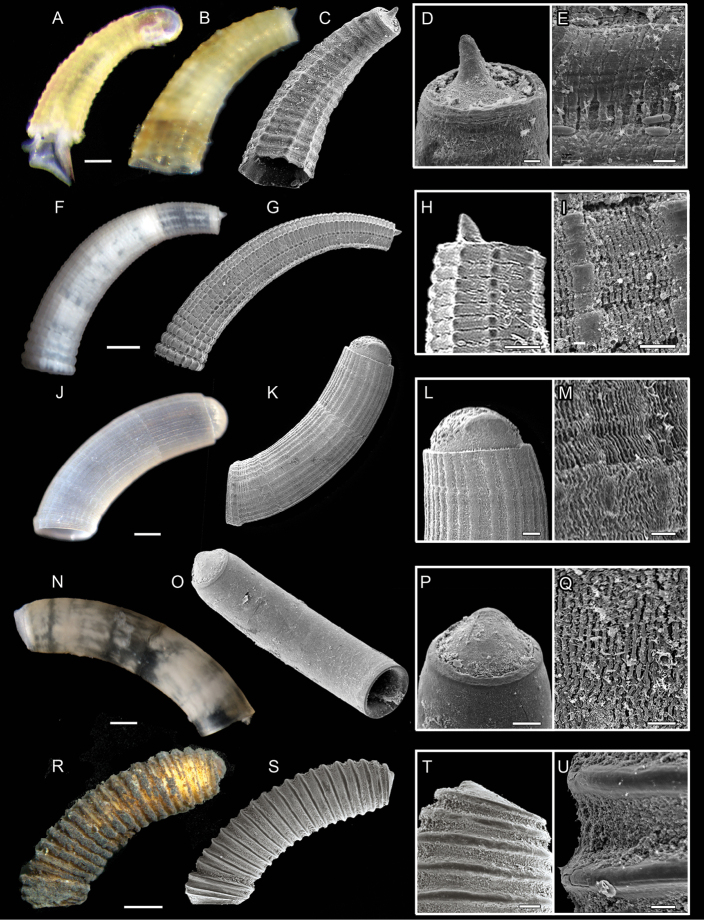
A–ECaecum
heptagonumA specimen USNM 1618866 juvenile specimen with larval shell still attached B–E specimen ZSM-Mol-20200030, juvenile specimen already resembling closely the adult form B light microscopic picture CSEM scan D close-up of mucro and E microsculpture F–IC.
cooperi, specimen MNHN-IM-2019-32 F light microscopic picture GSEM scan H close-up of mucro and I microsculpture whole specimen and close-up of mucro and microsculpture J–MC.
debile, specimen MNHN-IM-2019-27 J light microscopic picture KSEM scan L close-up of mucro and M microsculpture N–QC.
striatum, specimen ZSM-Mol-20100322 N light microscopic picture OSEM scan P close-up of mucro and Q microsculpture R–UC.
clathratum, specimen MNHN-IM-2019-17 R light microscopic picture SSEM scan T close-up of mucro and U microsculpture. Scale bars: 10 µm (D, E, I, Q); 20 µm (H, M, P, U); 100 µm (A, B, C, L, N, O, T); 200 µm (F, G, J, K whole specimen); 300 µm (R, S).